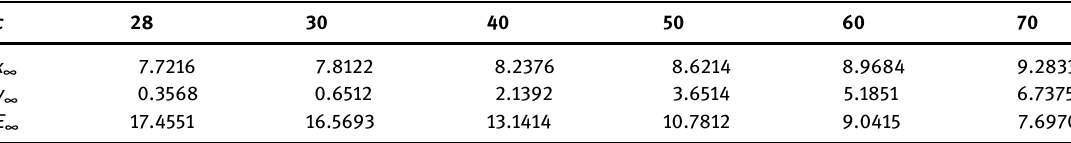
Table 1: The fi shing cost c changes from 28 to 70 with = = p p 7, 12